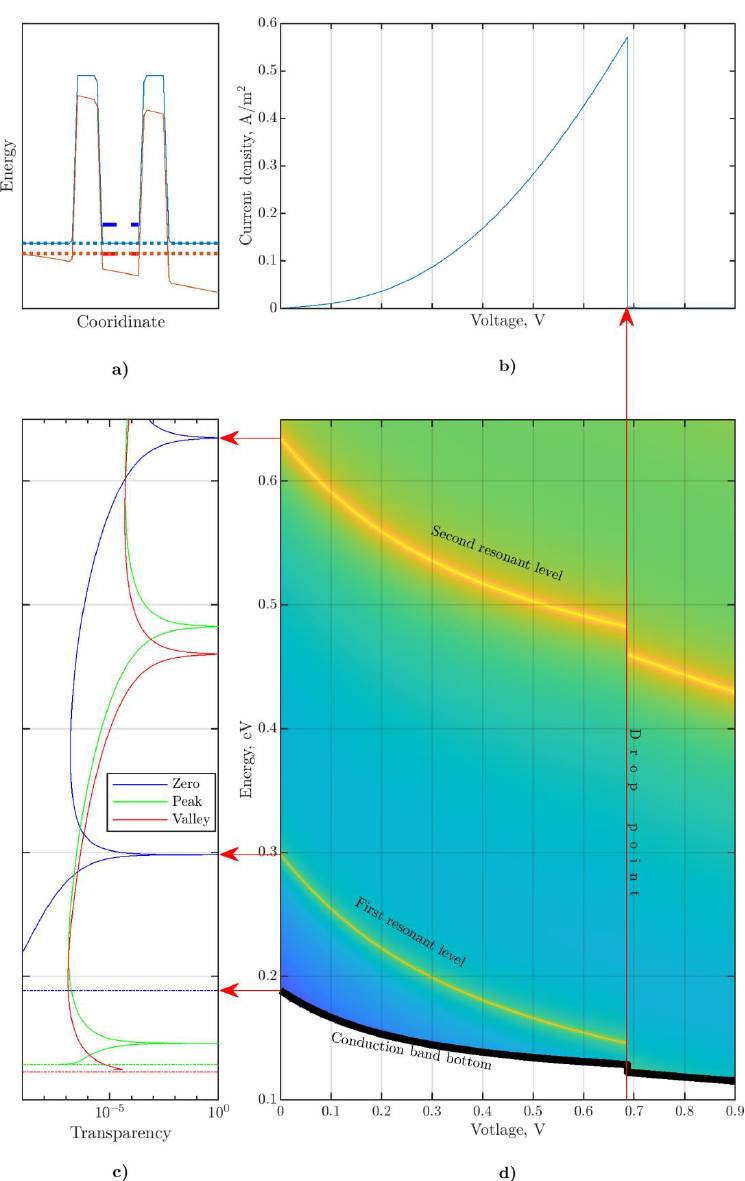
Figure 1. ( a ) Potential profile (solid lines), resonant levels (dashed lines) and bottom of conductivity zone at the source (dots); ( b ) I – V curve of the RTS; ( c ) tunnel transparency coefficient at zero, peak and valley voltages (dashed lines are bottom of conductivity zone at the source); the first (lowest) resonance level ε , second resonance level and bottom of conductivity zone at the source are shown; ( d ) tunnel transparency coefficient as a function of voltage.